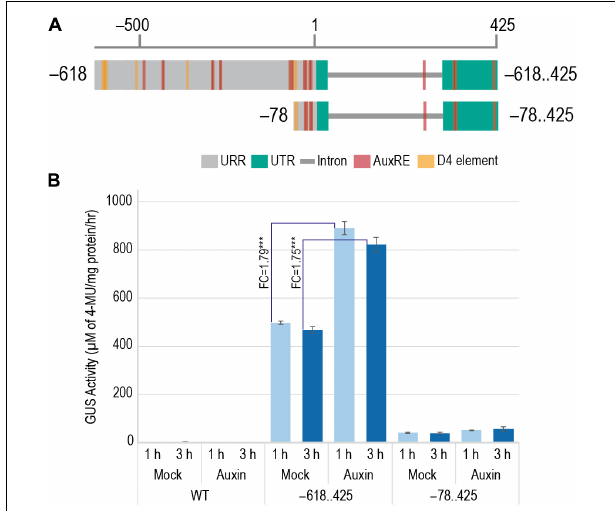
FIGURE 10 | Effect of addition of exogenous auxin on the GUS activity in 7-day-old WT and transgenic plants harboring –618..425:pMDC164 and –78..425:pMDC164 constructs. (A) Diagrammatic representation of the –618..425 and –78..425 regions showcasing the auxin-responsive elements, AuxRE and D4 elements. (B) A bar graph showing GUS activity as µ M of 4-MU/mg protein/h in response to exogenous IAA- and mock-treated plants. Fold changes in GUS activity between mock and auxin-induced samples for –618..425:pMDC164 construct have been indicated. Data represent information obtained from three biological replicates. Three asterisks represent Student’s t -test p -value < 0.001, and standard error is represented as error